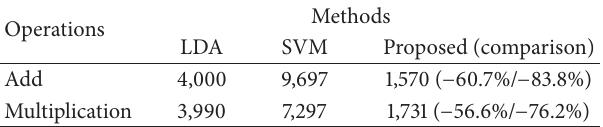
Table 2: Experimental results of number of arithmetic